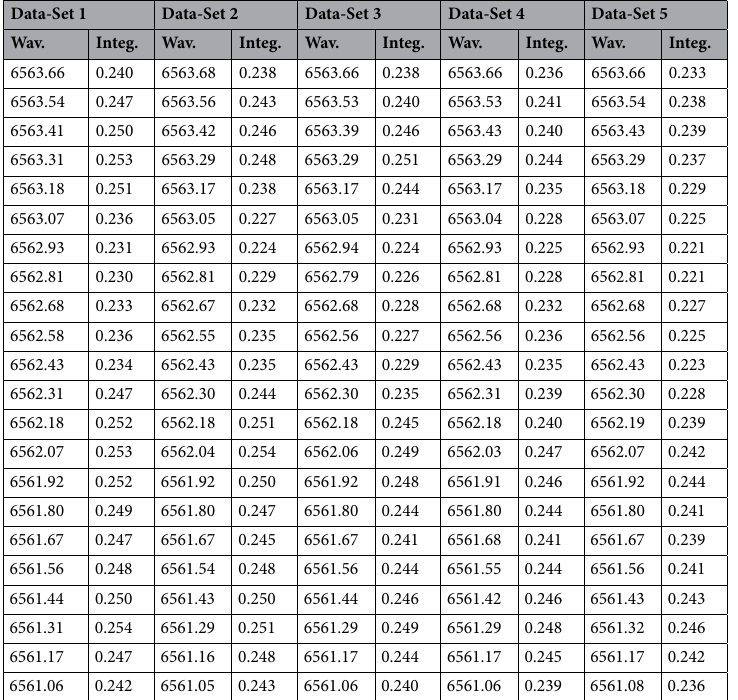
Table 1. Test the integral constant at 110 LCVR passband positions from the 5 data sets. Each value (Integ., dimensionless) is integrated in the interval of 20 Å. The center wavelength (Wav., [Å]) of passband corresponding to each integral value is marked in the